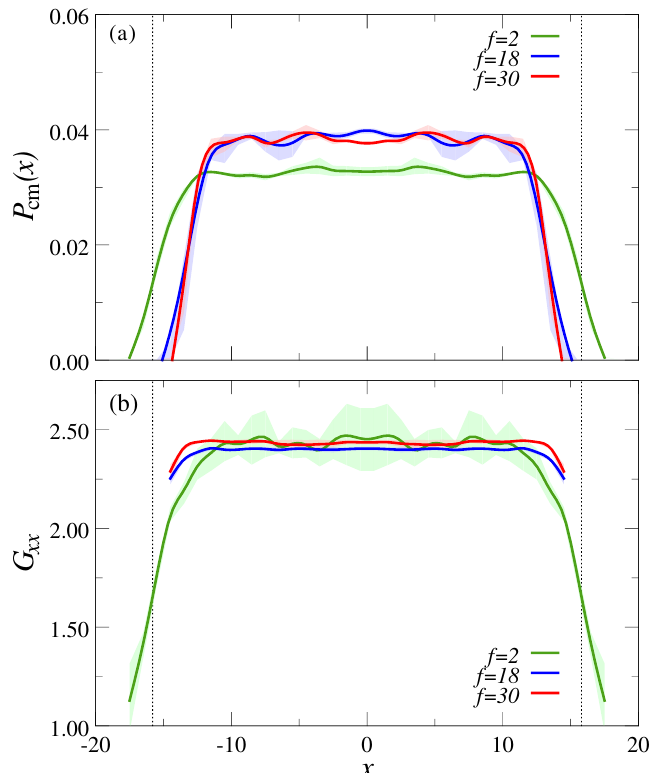
Figure 2. ( a ) Center of mass probability distribution normal to the channel walls, P cm ( x ) , for various arm numbers f at rest; ( b ) Component of the radius of gyration tensor normal to the walls ( G xx ) as a function of center of mass distance x . In both panels, the shaded regions around the curves indicate our measurement uncertainty. The dotted vertical lines indicate the excluded regions of width R g near the channel